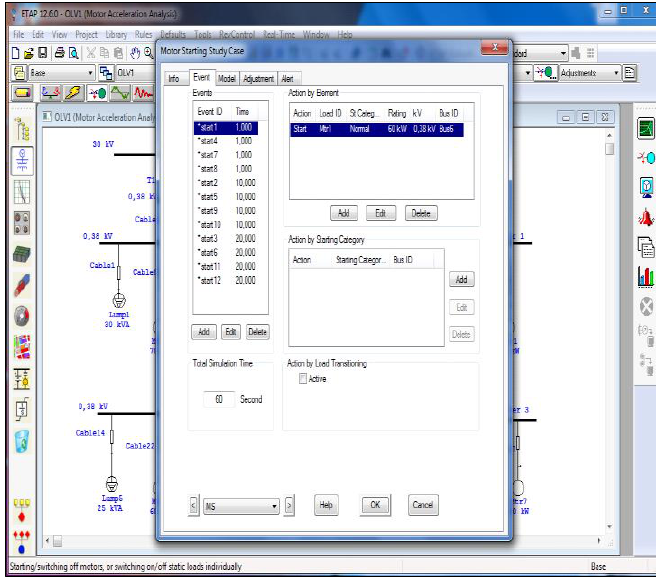
Figure 16: Adjusting the motors starting time. Source: Authors, (2020).